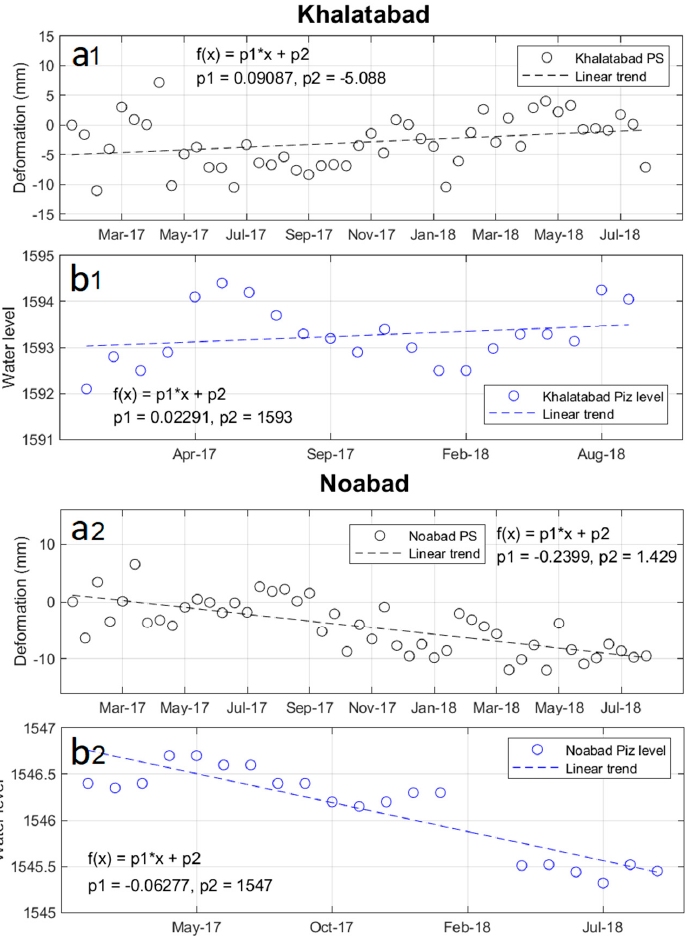
Figure 12. Comparing the PS-InSAR results and hydrological information. Figures ( a1 , a2 ) represent the temporal deformation behavior of the PSs close to the Khalatabad and Noabad piezometric wells, respectively. Figures ( b1 , b2 ) indicate piezometric water level fluctuation from 2017 to 2018/08. The linear interpolated lines are displayed using a dashed line, and their information is also shown on each subfigure.